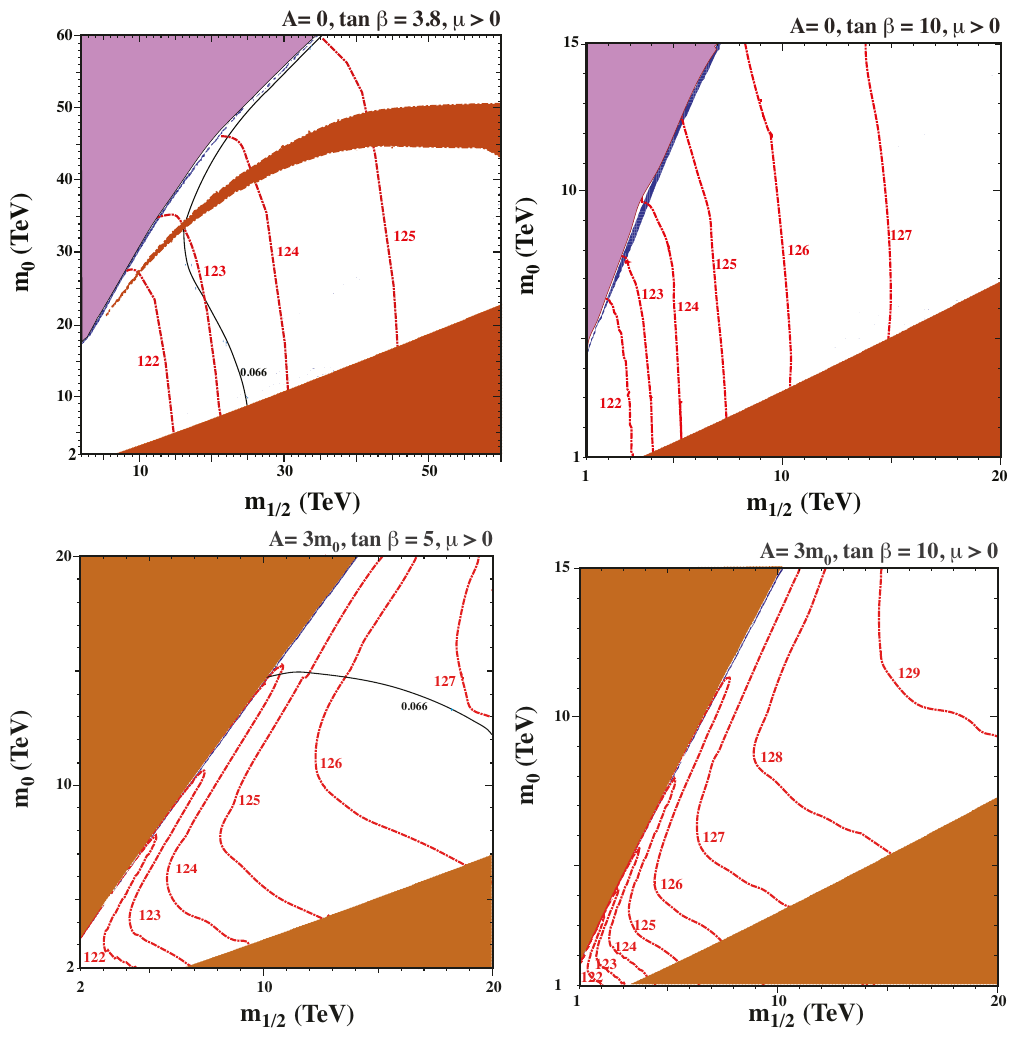
Figure 1 . The ( m 1 , m 0 ) plane for A 0 = 0 and tan β = 3 . 8 (case A — upper left); A 0 = 0 and / 2 tan β = 10 (case B — upper right); A 0 = 3 m 0 and tan β = 5 (case C — lower left); A 0 = 3 m 0 and tan β = 10 (case D — lower right) all with µ > 0 in the CMSSM with GUT-scale universality. Here all CP-violating phases are set to 0. The red dot-dashed contours show the lightest Higgs mass as calculated using FeynHiggs [115]. In the dark red shaded regions, the LSP is either lighter stau, stop or chargino as described in the text. In the blue strip along either the region with no electroweak symmetry breaking (shaded pink in the upper two panels) or the stop LSP region, the LSP has an enlarged relic density range, 0 . 02 < Ω χ h 2 < 0 . 6 , to enhance its visibility. The black lines seen in both of the left panels show the constraint from the lifetime of p K + ¯ ν →